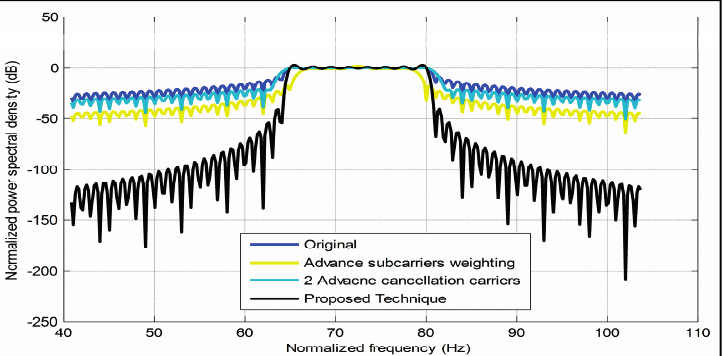
Figure 5. The PSD comparison between the proposed technique and existing techniques including ASW and ACC.